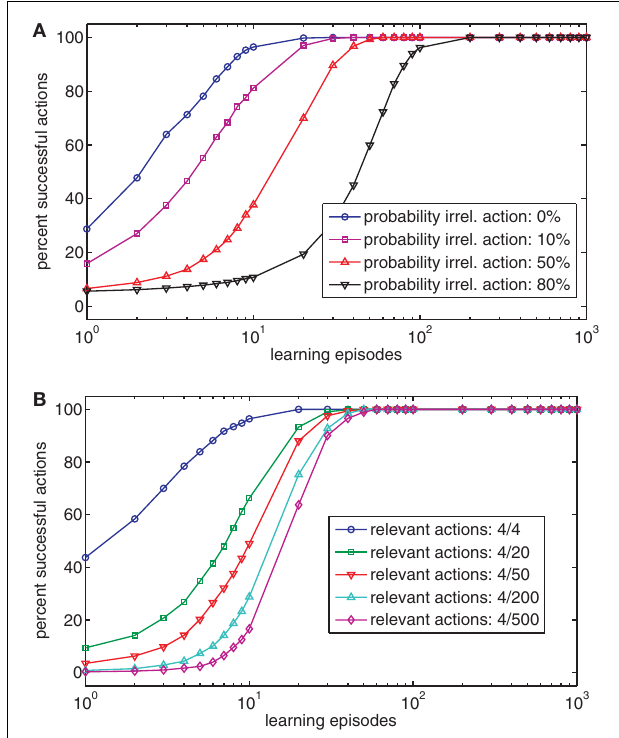
FIGURE 3 | (A) The chart shows the effect of the relative frequency of activating irrelevant action nodes on ideomotor learning. (B) The chart shows the effect of the ratio of relevant and irrelevant actions on ideomotor